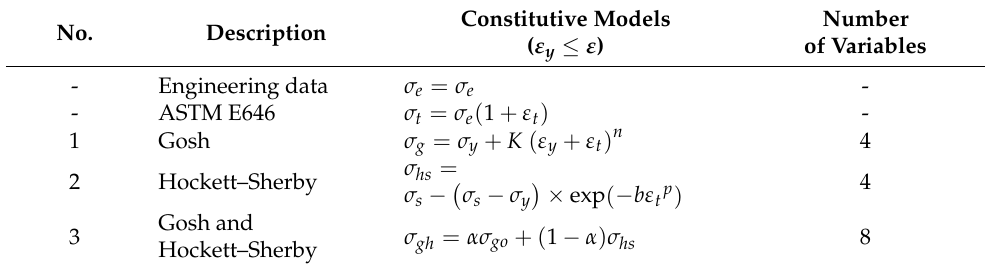
Table 2. Various constitutive model details for FE